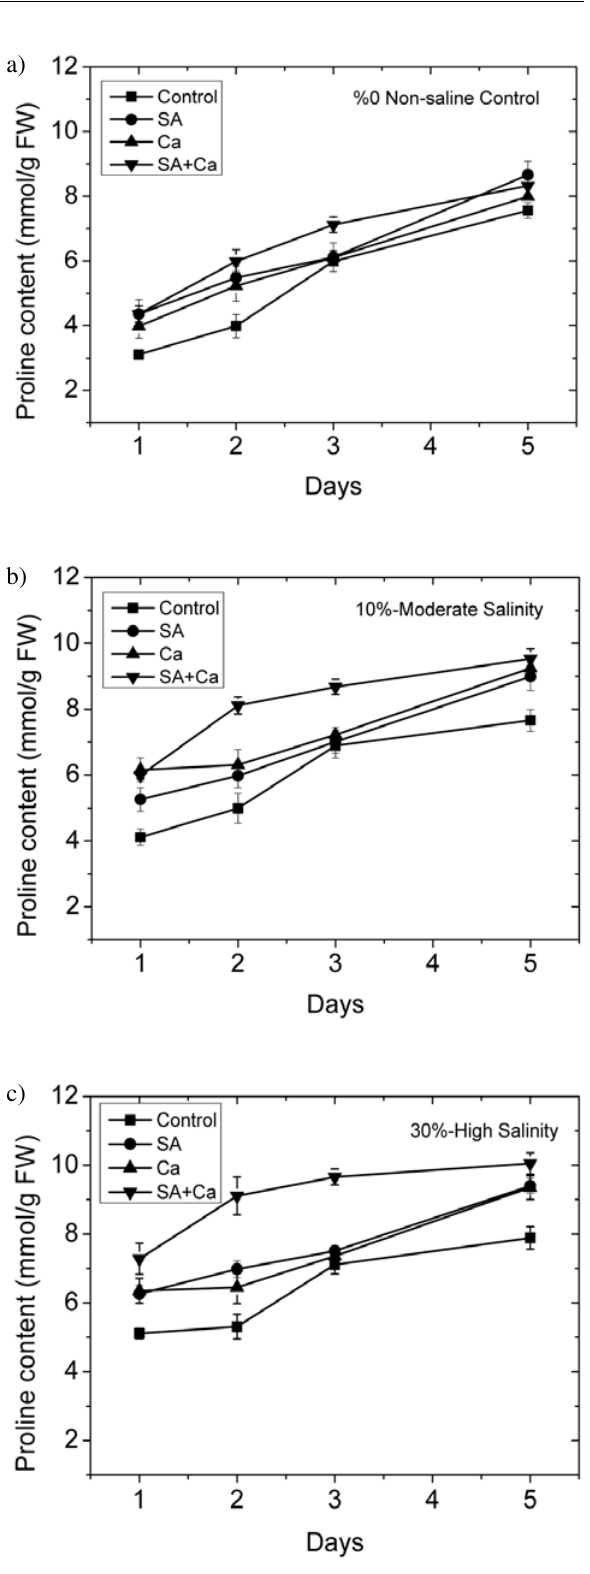
Figure 1. Proline contents in seedlings of wheat under three dif- ferent stres conditions a) Non-saline b) 10%-Moderate salinity and c) 30%-High salinity: with four traetments (- (cid:2) -), control; (- (cid:3) -), 0.5 mM SA; (- (cid:2) -), 50 mM Ca +2 ; (- (cid:3) -), 0.5 mM SA+50 mM Ca